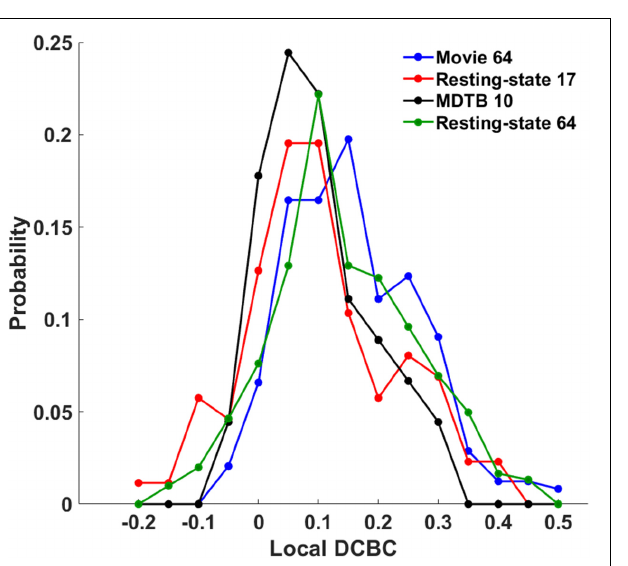
FIGURE 6 | The histograms of the local DCBC values in the four